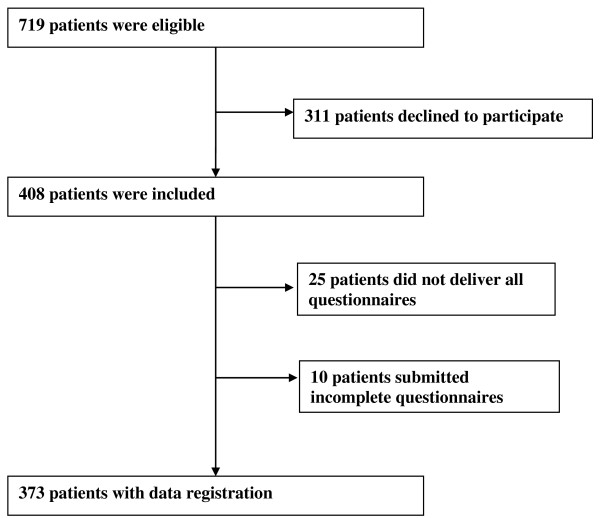
Flow chart of study.